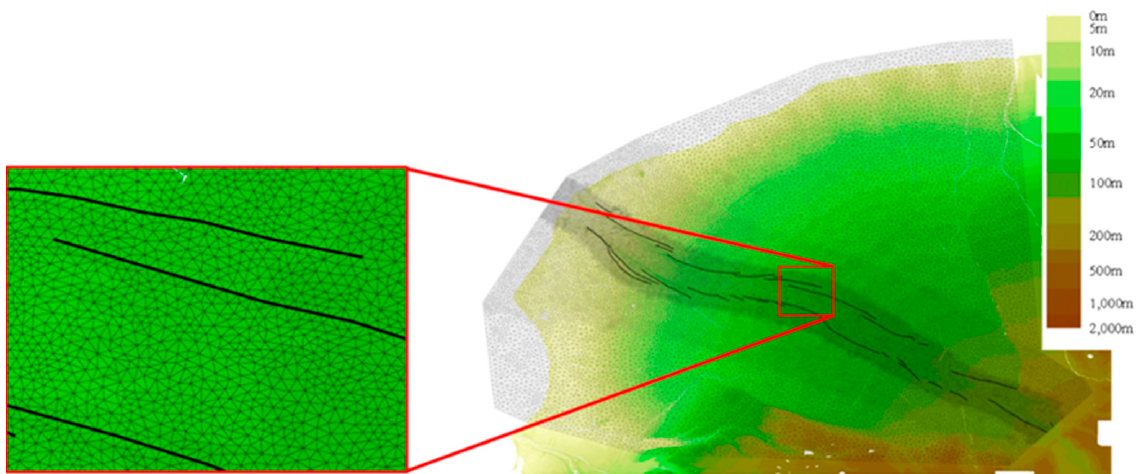
Figure 9. Triangular mesh system.